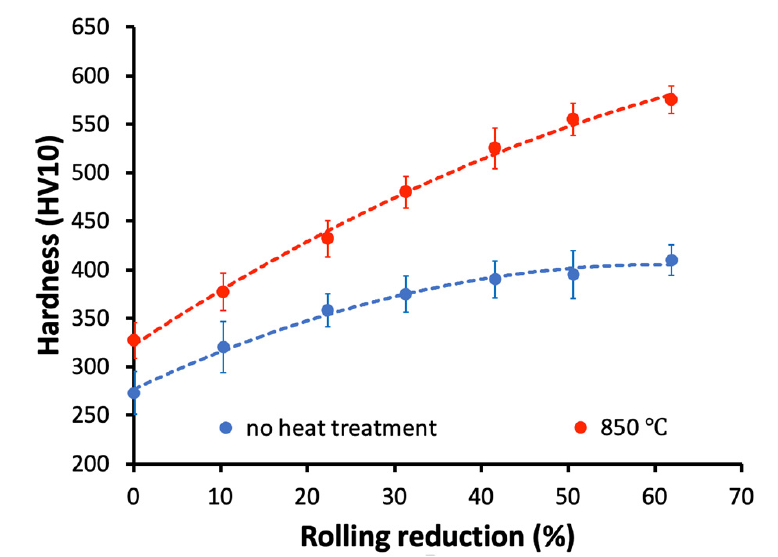
Figure 3. Vickers hardness of the cold-rolled (blue) and cold-rolled + heat-treated (red) samples vs. rolling reduction.